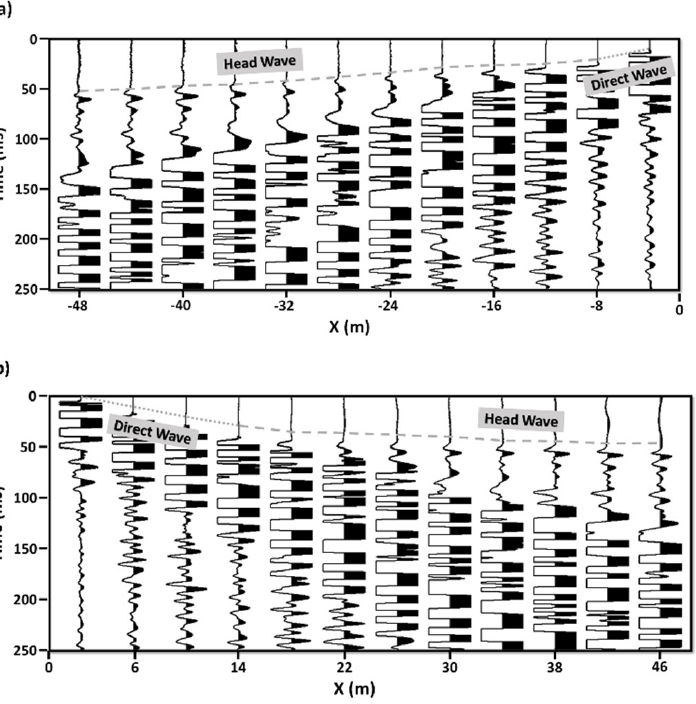
Figure 4. Two different recorded shot gathers (raw data): ( a ) shot gather 1 (down-dip); ( b ) shot gather 3 (up-dip), with 12 traces each.